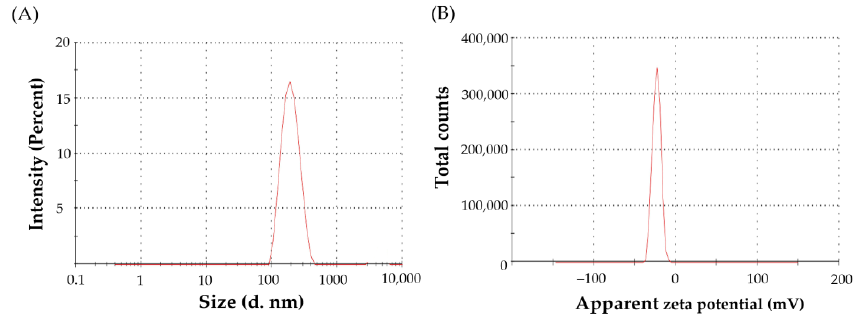
Figure 3. ( A ) Vesicle size and ( B ) Zeta potential of optimized SMV-BS. The zeta potential represents a key indicator for the storage stability and in vivo be-